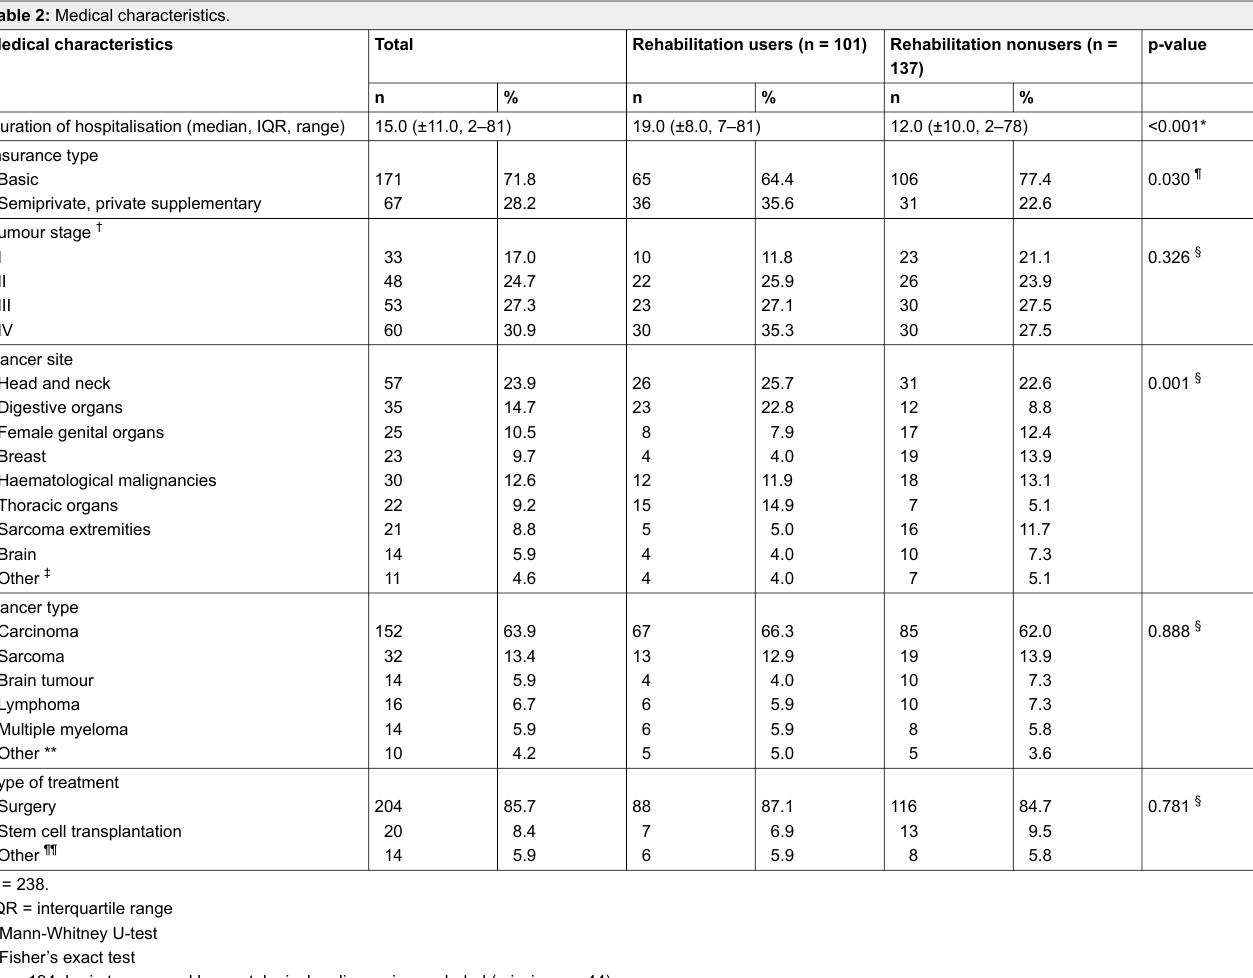
Table 2: Medical